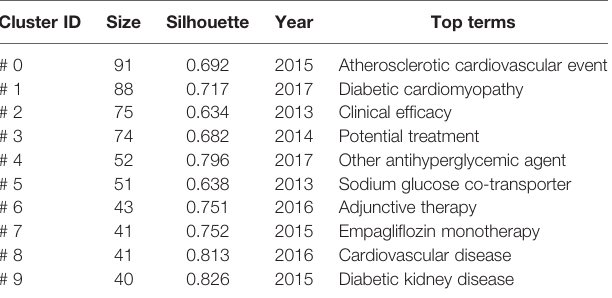
TABLE 5 | Top 10 largest clusters of co-cited references in SGLT2 inhibitors in CV